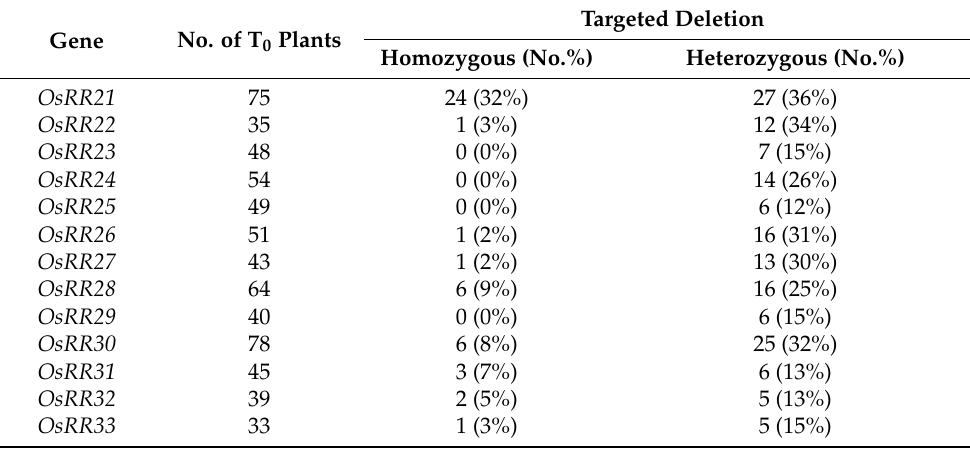
Table 2. Summary of genome editing results in T 0 transgenic rice by